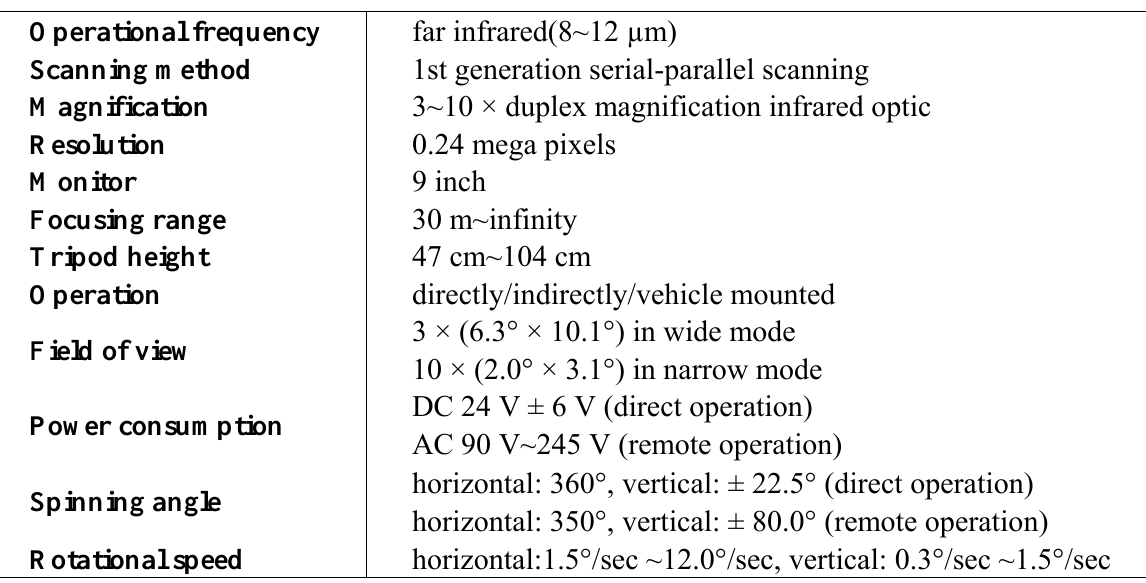
Table 1. The system (Model-TAS-970K)